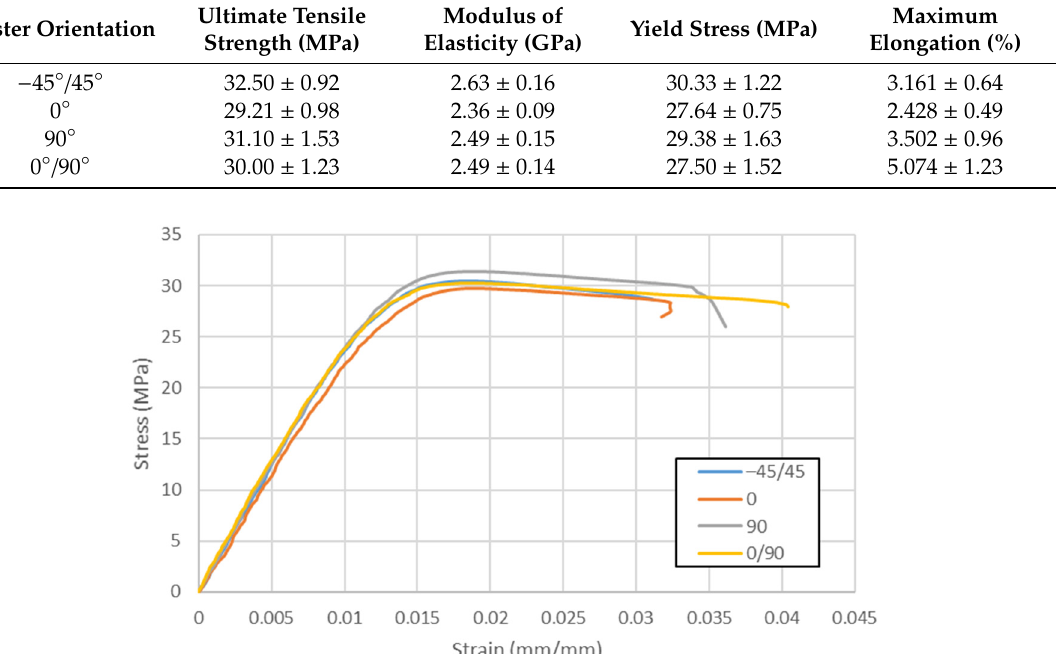
Table 2. Tensile Testing Results.